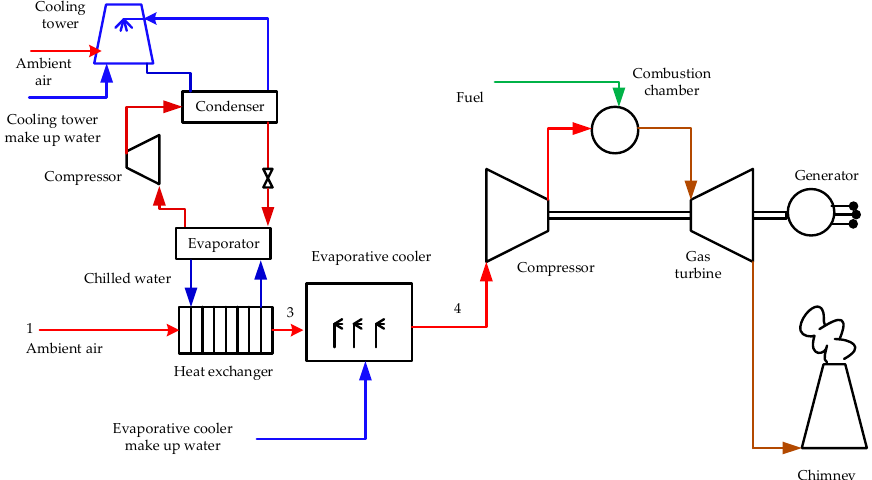
Figure 5. Gas turbine with evaporative vapor-compression refrigeration inlet cooling.